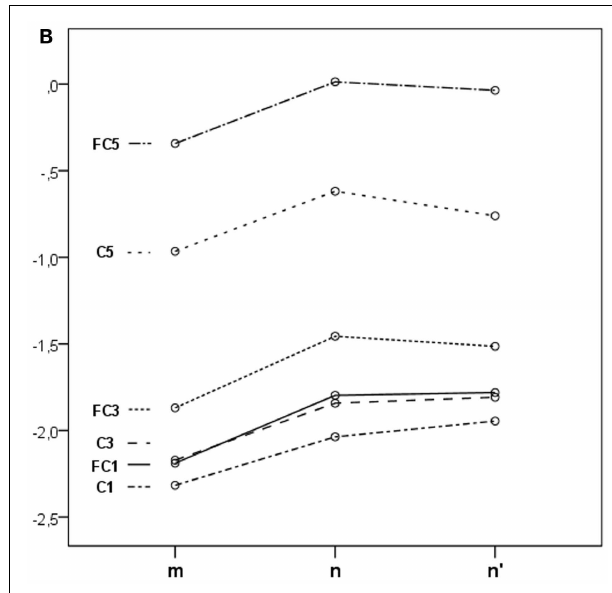
FIGURE 3 | Continued (B) The mean amplitudes (in µ V, averaged over the N100-time window) elicited by the isolated nasals at each electrode in the selected region (FC1, FC3, FC5, C1, C3, C5).